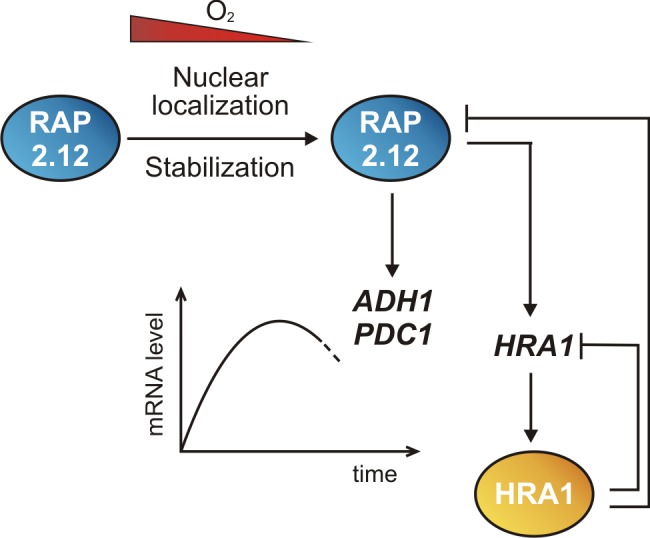
Model summarizing how the balanced action of RAP2.12 and HRA1 tunes transcription of hypoxia target genes.In plant cells, hypoxia promotes the relocalization of RAP2.12 to the nucleus, which triggers the expression of HRA1 and other RAP2.12 target genes. Once synthesized, the encoded HRA1 protein generates two negative loops of feedback regulation, one acting on RAP2.12 and another on HRA1 itself. The first one dampens RAP2.12 activity, thereby limiting the anaerobic gene expression after its initial burst. The negative self-regulation is, instead, supposed to contribute to the subsequent down-regulation of HRA1 and makes a later wave of anaerobic gene expression possible under prolonged hypoxia.